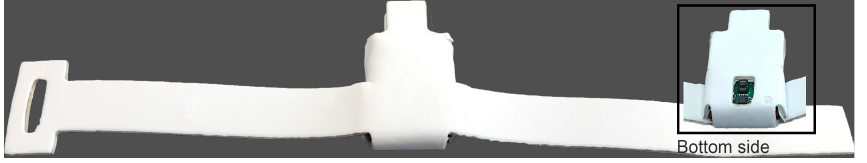
Figure 2. New design of the personal monitoring device.